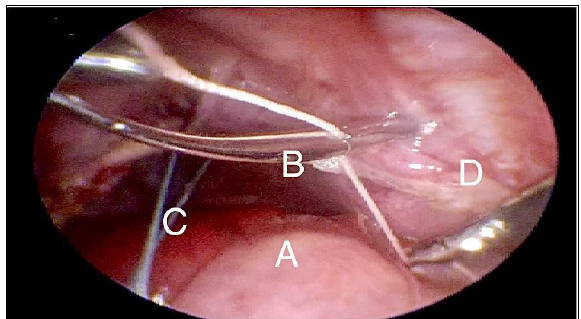
Figure 2: The use of the Reverdin needle. A: Diaphragmatic defect; B: Reverdin needle; C: Braided Polyester suture 2.0; D: Rim.